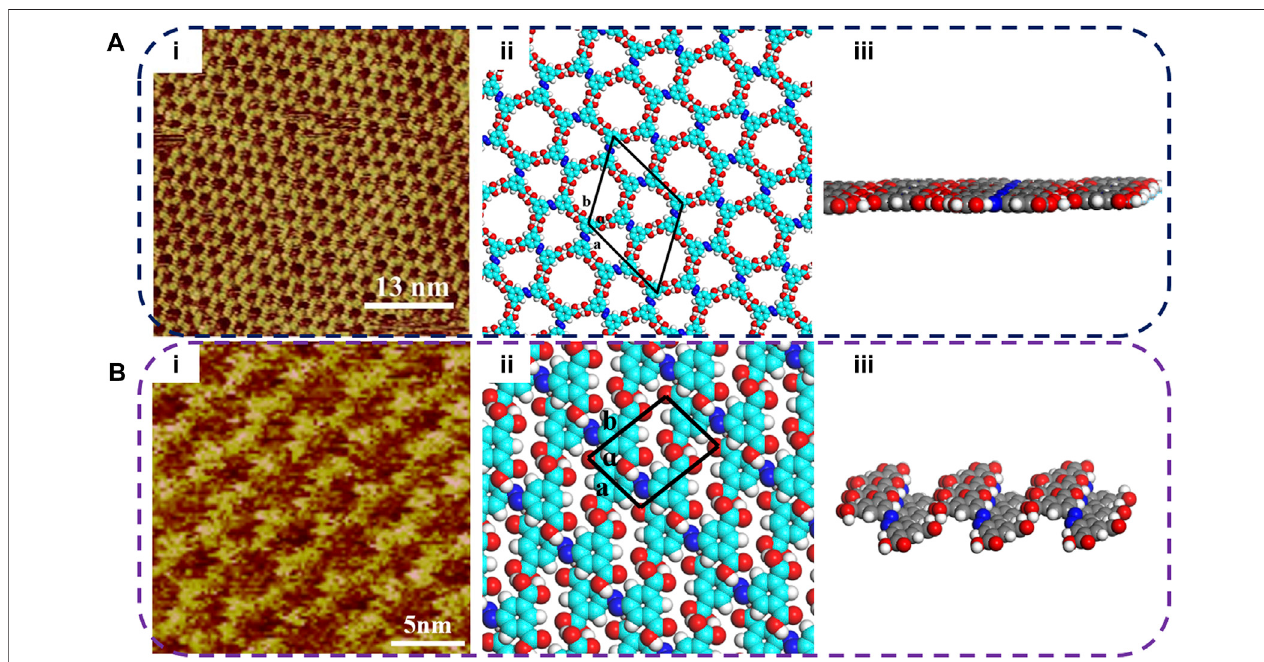
FIGURE 1 | STM images of the NN4A self-assembly template networks structures at the HOPG interface under light irradiation. (A) NN4A: (i) High resolution; (ii) The simulated molecular packing structure; (iii) 3D structural front view of NN4A molecular layer. (B) NN4A-uv: (i) High resolution; (ii) The simulated molecular packing structure; (iii) 3D structural front view of NN4A-uv molecular layer. Tunneling conditions: I set (cid:2) 389 pA, V bias (cid:2) 576 mV. The irradiation time of UV lamp with 360 nm is 40 min, and the power is 8 W/m.